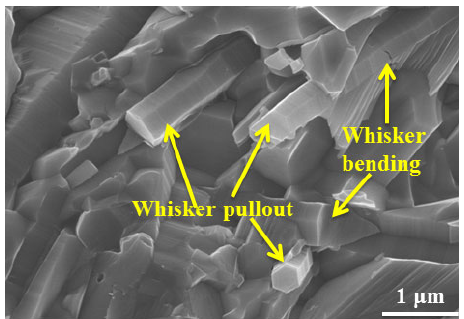
Fig. 7 SEM image of the fractured surface for the SiC w / Ti 3 SiC 2 containing 10 wt% SiC w